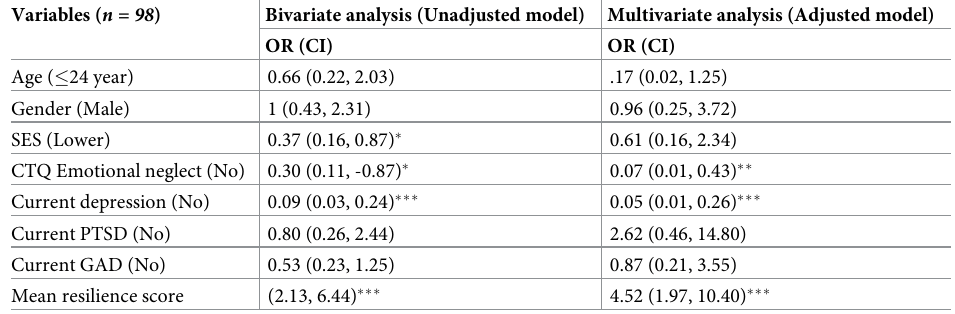
Table 4. Factors associated with better QOL.